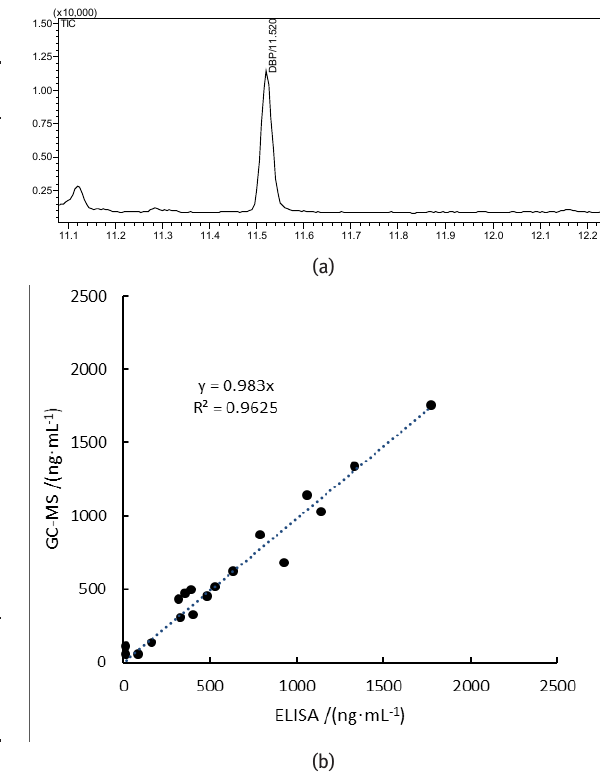
Figure 5: Validation of the assay with GC-MS. a, A typical GC-MS chromatogram for DBP in liquor samples. b, correlation of GC-MS and ELISA analysis of certain